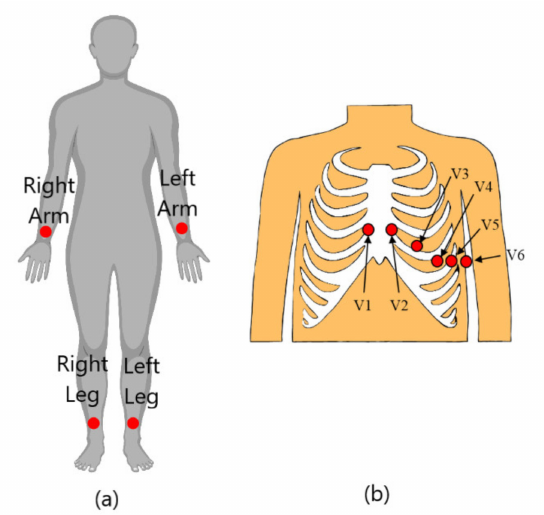
Figure 4. Possible electrode placements for ECG recordings [19]: ( a ) electrode placement for limbs lead configuration; ( b ) electrode placement for chest lead configuration